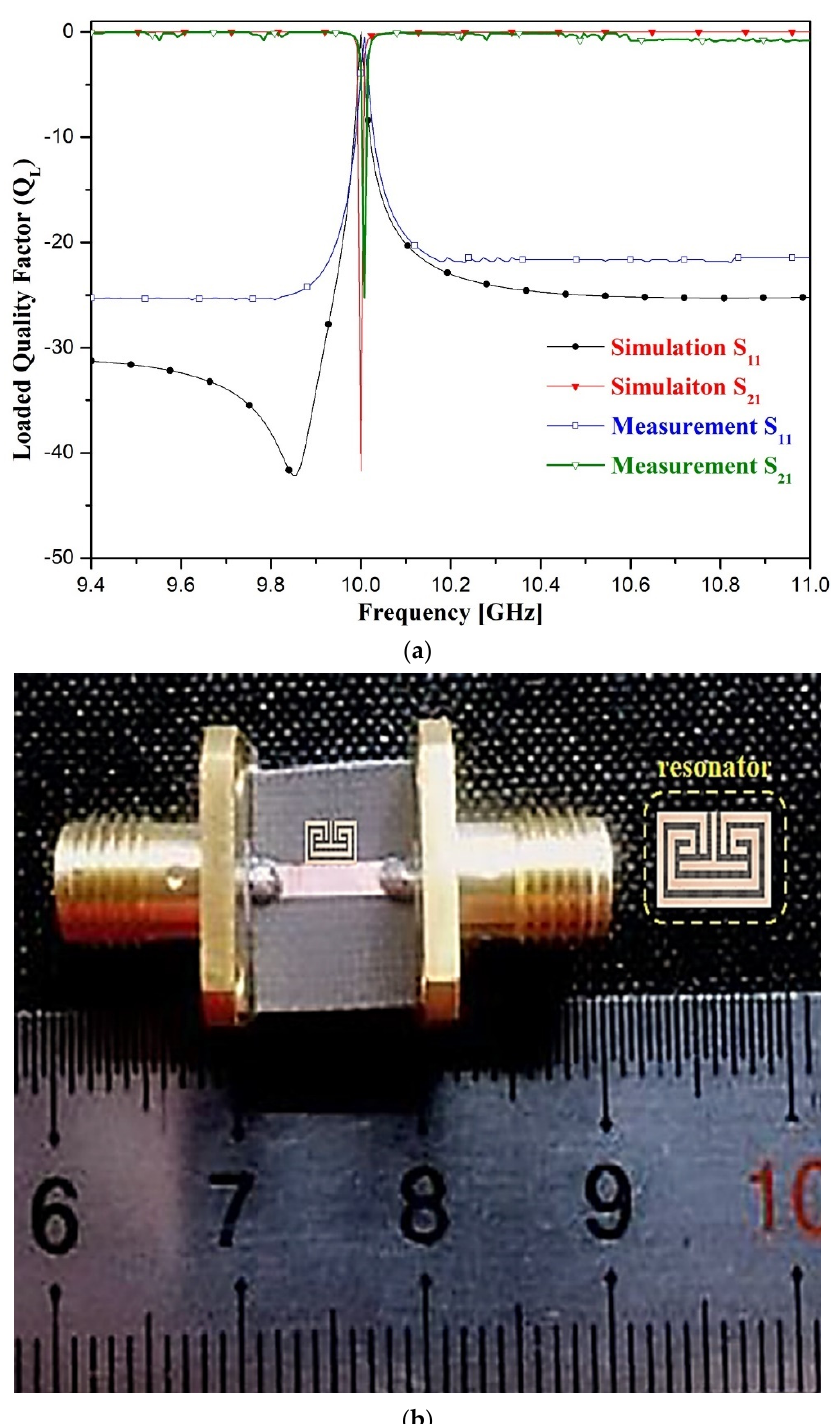
Figure 6. Fabrication and experimental results of the proposed resonator: ( a ) simulation and meas- urement results; ( b ) fabrication.